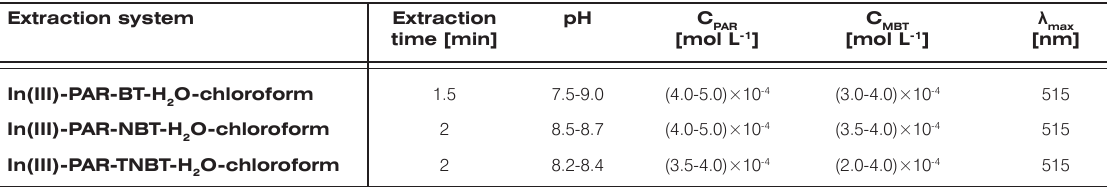
Table 2. Optimum operating conditions. a